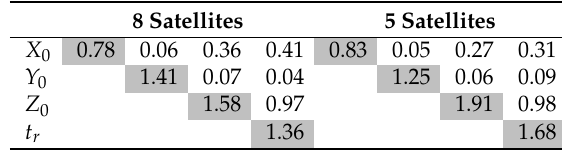
Table 3. Interpreted variance matrix Q ˆ The unit of X 0 , Y 0 , Z 0 , t r is all [m].